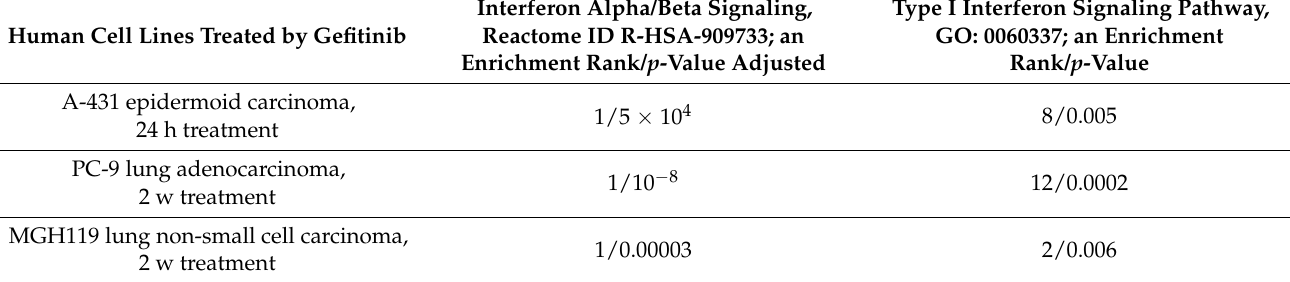
Table 3. Type I interferon signaling pathway is enriched by differentially expressed genes in available RNA seq datasets obtained for cancer cell lines treated with gefitinib [36,38]. Pathways were generated by Reactome [39] and Gene Ontology [40]. The “Enrichment rank” means a rank in a list sorted by enrichment’s p